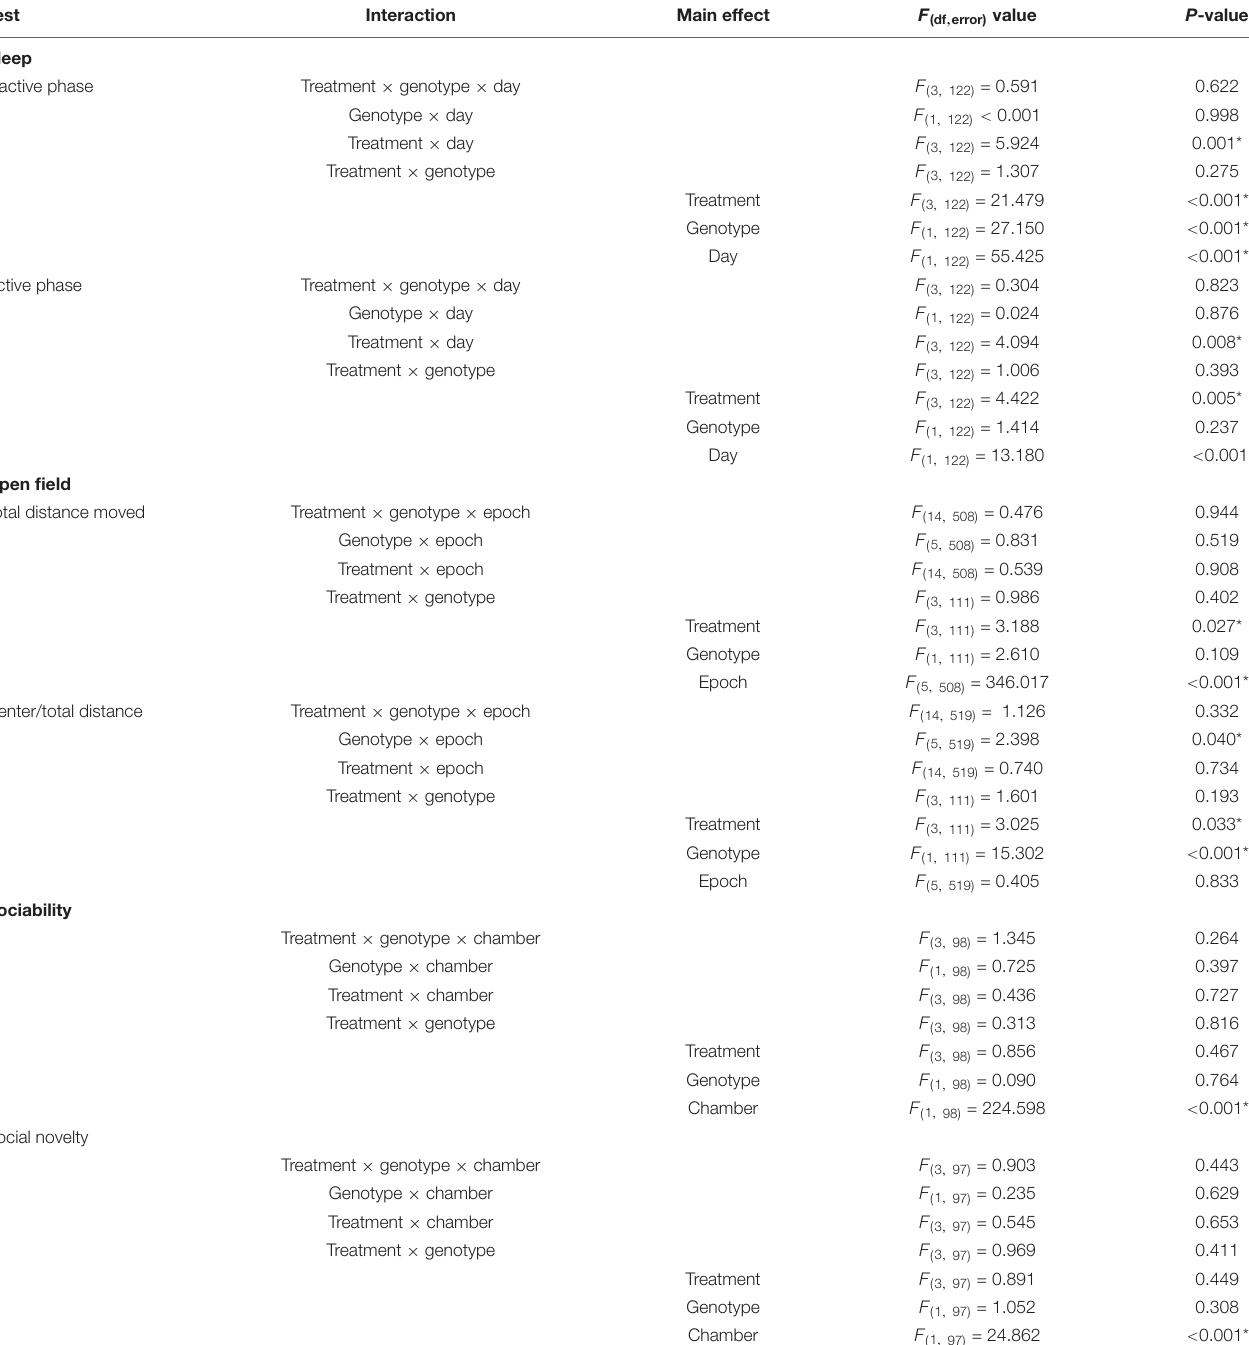
TABLE 1 | Effects of hypnotics: results of mixed model